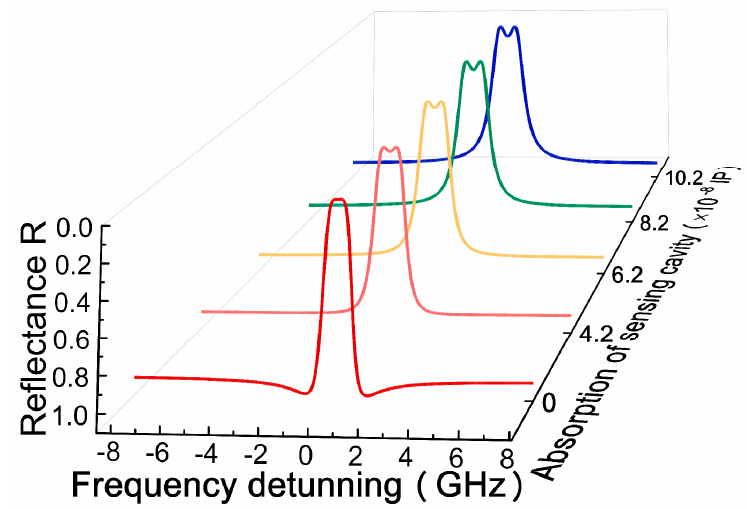
Figure 6. Splitting process of spectrum with the increase in absorption.